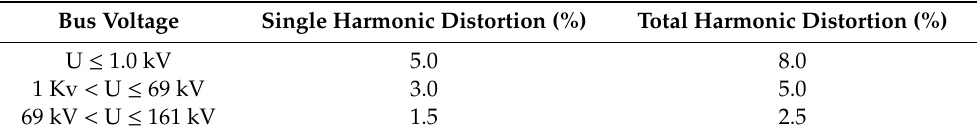
Table 1. IEEE STD 519—2014 harmonic voltage distortion